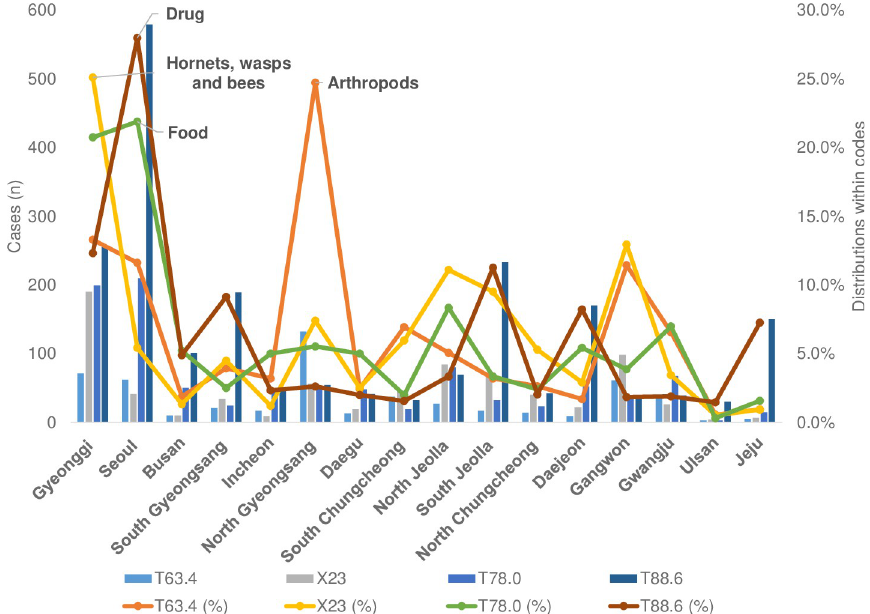
Fig 8. Regional distribution of anaphylaxis diagnostic codes through 2007–2013. The names of the regions are in order of the highest mid-population. T63.4 venom of other arthropods; T78.0, anaphylactic shock due to adverse food reaction; X23, contact with hornets, wasps, and bees; T88.6 (anaphylactic shock due to the adverse effect of an appropriate drug or medication properly